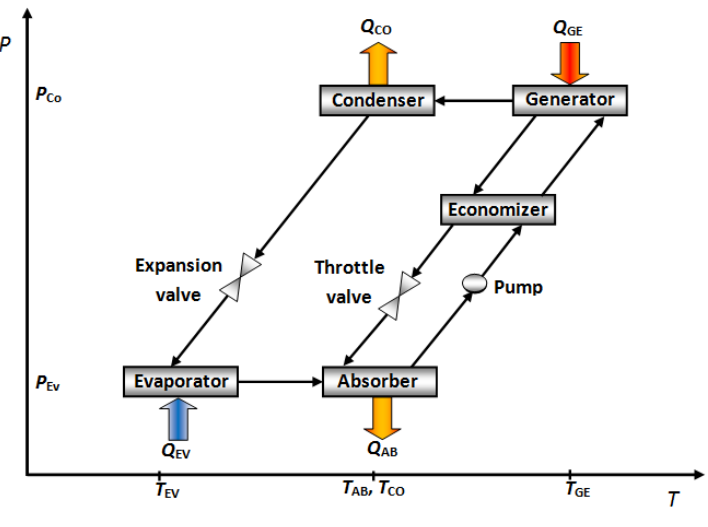
Figure 1. Schematic diagram of absorption cooling